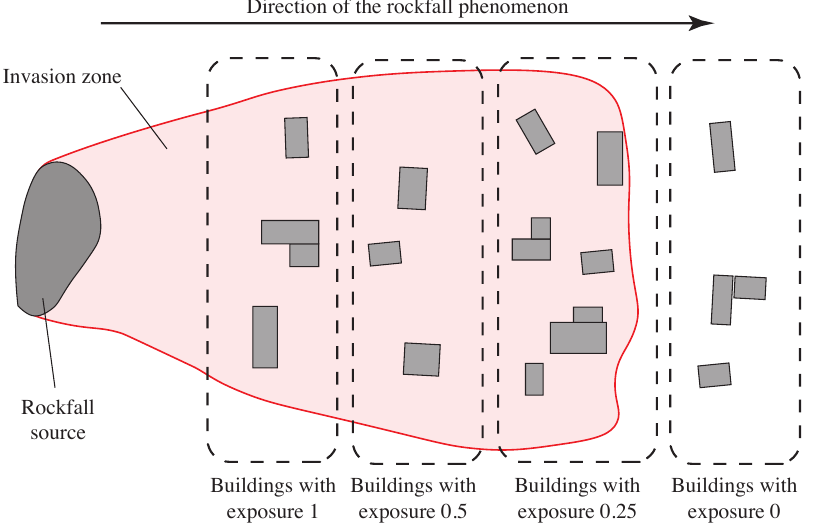
Figure 7. Sketch used for the definition of the physical exposure for buildings within the invasion zone. Buildings with exposure 1 belong to the first row of distance from the rockfall source. Buildings hidden by a single row of structures (second row of distances from the rockfall source) are identi- fied with a value of exposure equal to 0.5. Buildings belonging to the third and higher rows are characterized by an exposure value of 0.25. Outside the invasion zone, the exposure was set to